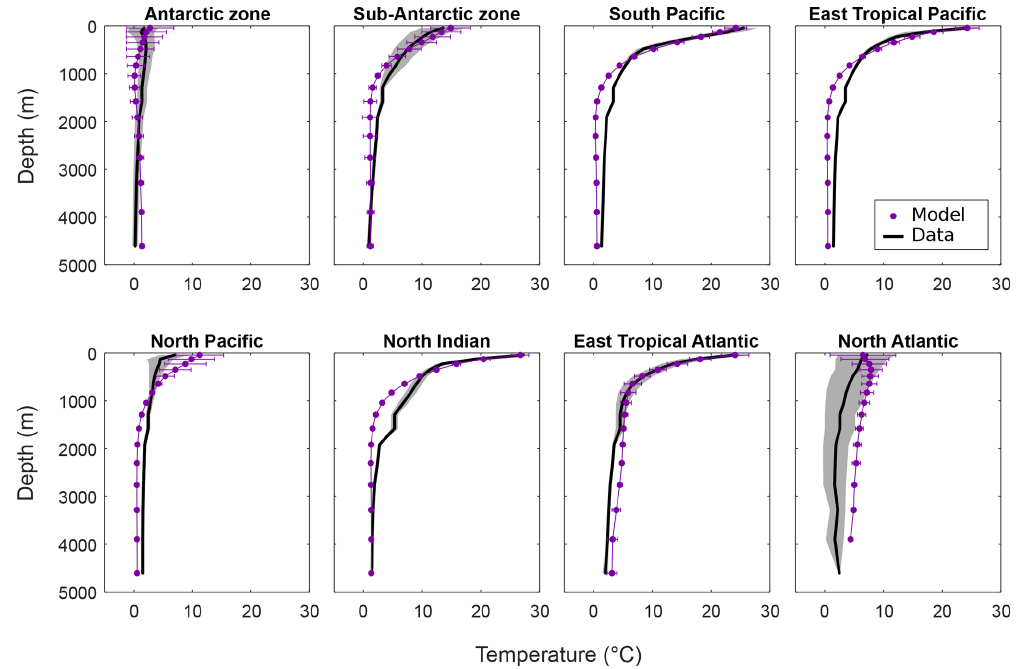
Figure 4. Temperature ( ◦ C) per depth by region for the model and data (mean and standard deviation). Data from WOA 2009 (Levitus et al., 2010). Table 4. Statistics for the fit of the model to phosphate and oxygen distribution in the present day for the STND, TDEP (best fit), and TDEP + TDOM simulations. Statistics are shown as standard deviation (SD) in µmolL − 1 , centred root mean square difference (CRMSD) in µmolL − 1 , and correlation to data. TDEP + TDOM is described in Sect. 5.2. Standard deviation CRMSD correlation Data STND TDEP TDEP + TDOM